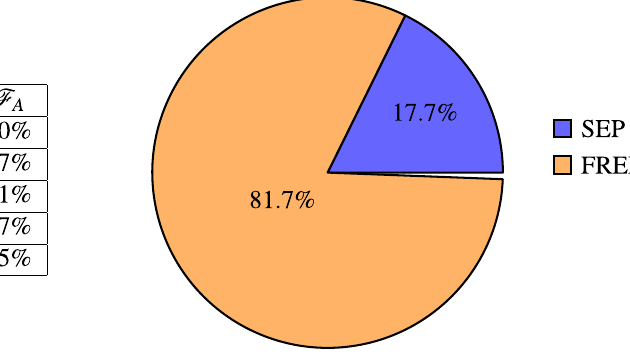
Figure 3. Entanglement classes and their relative volumes in F A .